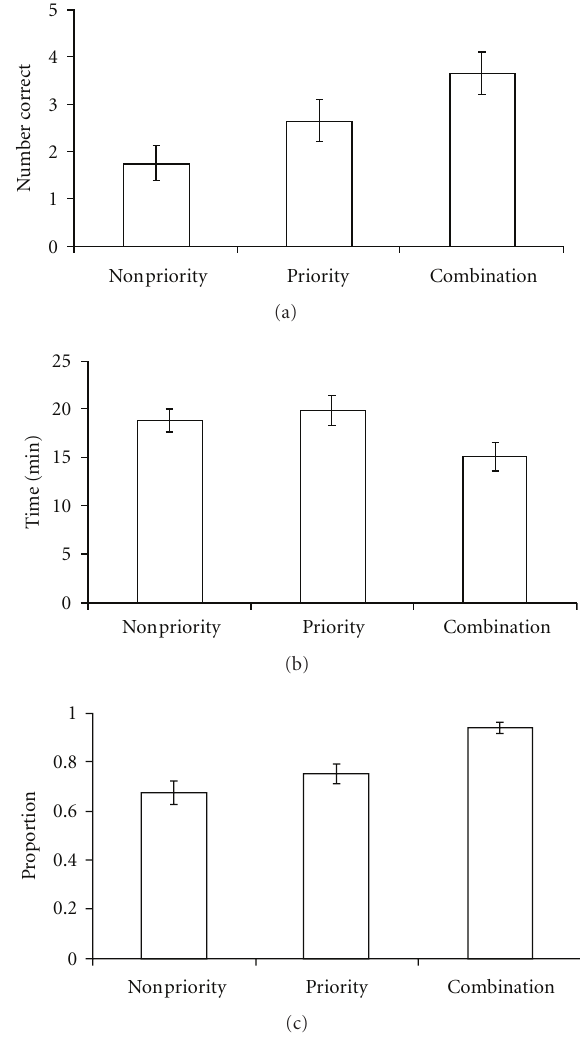
Figure 2: Mean ( ± S.E. n = 27) (a) success rate of correctly identifying five individuals, (b) time taken to complete five identifi- cations, (c) proportion of key successfully navigated during identi-